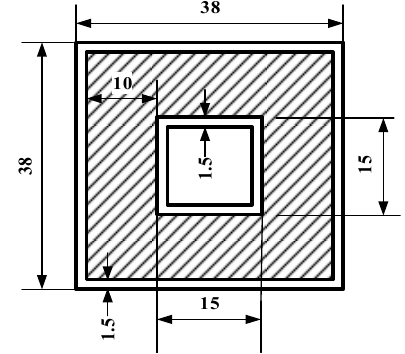
Figure 2. Geometric dimensions of composite sandwich laminated box beams.